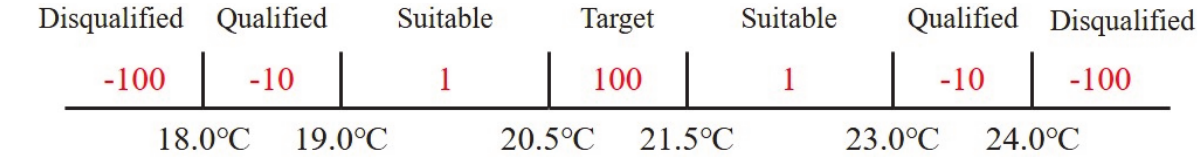
Figure 6. Design of reward function 2.